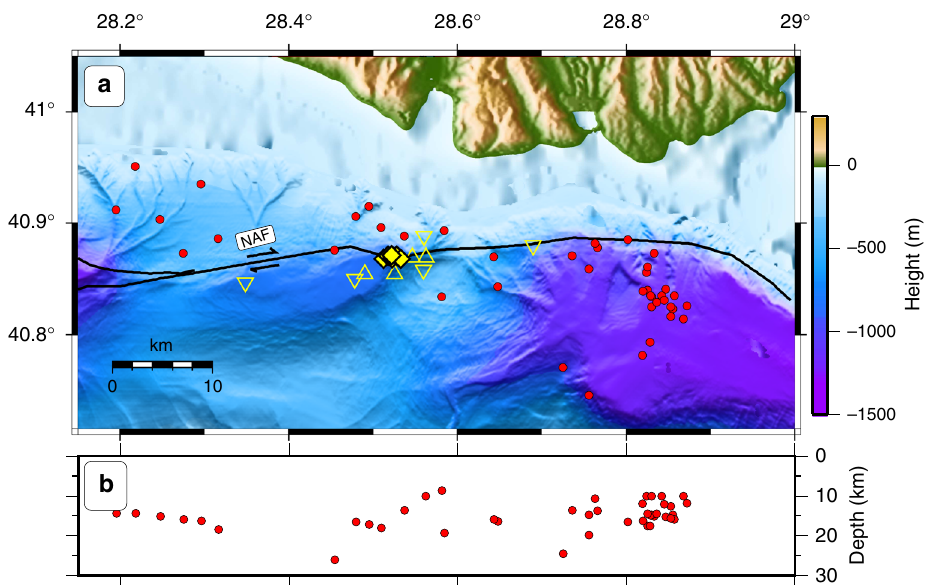
Fig. 6 Seismicity located with the ocean bottom seismometer data. Microseismicity locations in map view ( a ) and projected along a vertical west-east trending pro fi le ( b ). The OBSs were fi rst deployed in a very small aperture array (29 October 2014 until 25 April 2015, upright triangles) and then re- deployed along the NAF (26 April 2015 until 13 April 2016; inverted triangles). Red circles show the events located with phases from OBS data combined with arrival times from land stations (KOERI). Yellow diamonds clustered near the OBSs show the geodetic stations. Bathymetry from ref. 30 , topography from ref. 31 and fault traces from ref.